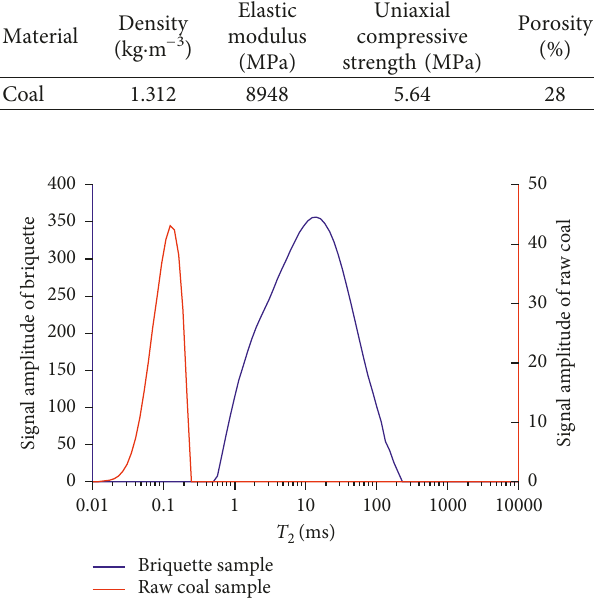
Figure 4: Nuclear magnetic resonance (NMR) test results of coal